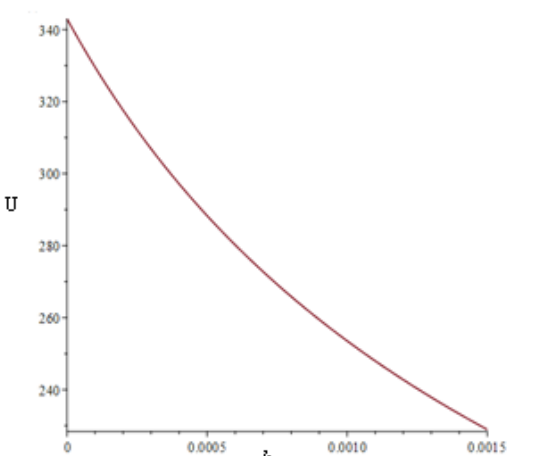
Figure 4. Graph of acoustic velocity versus low water concentrations. SI speeds. For low concentra ‐ tions of water in the air (fog).